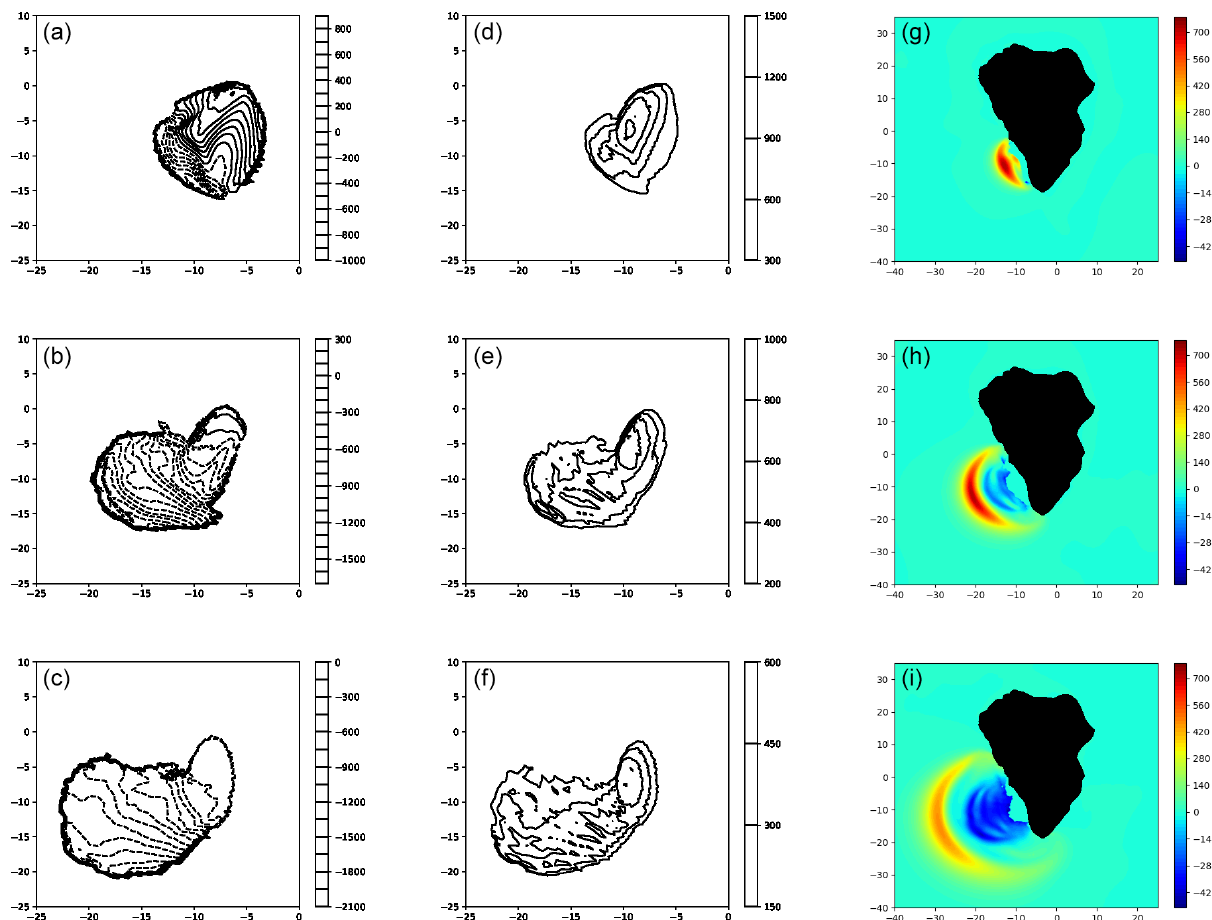
Figure 8. Snapshots of slide upper free surface, thickness and corresponding water-free surface for the inviscid case (Abadie et al., 2012) ( a–c , d–f , g–i ), respectively, for the 80km 3 scenario at t = 60s (a, d, g) , 120s (b, e, h) and 180s (c, f, i)